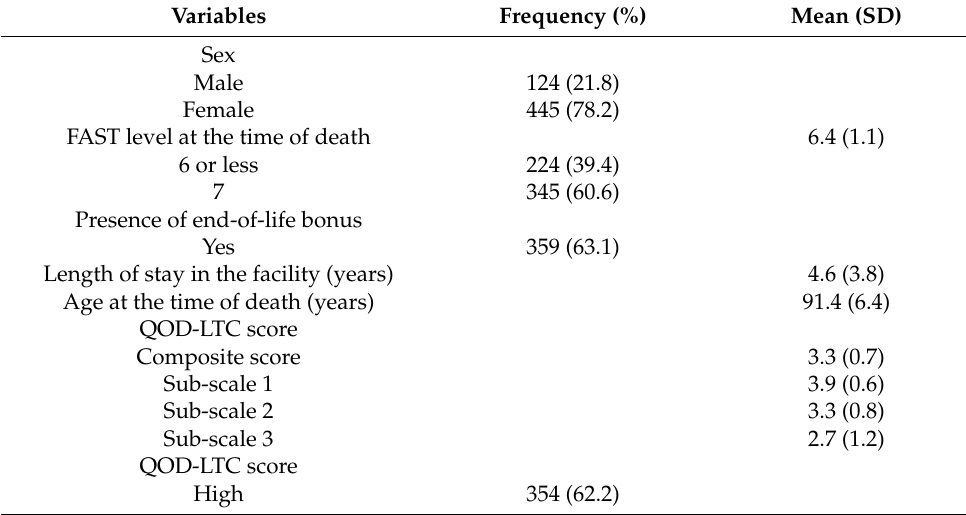
Table 2. Characteristics of the recently deceased residents ( N =